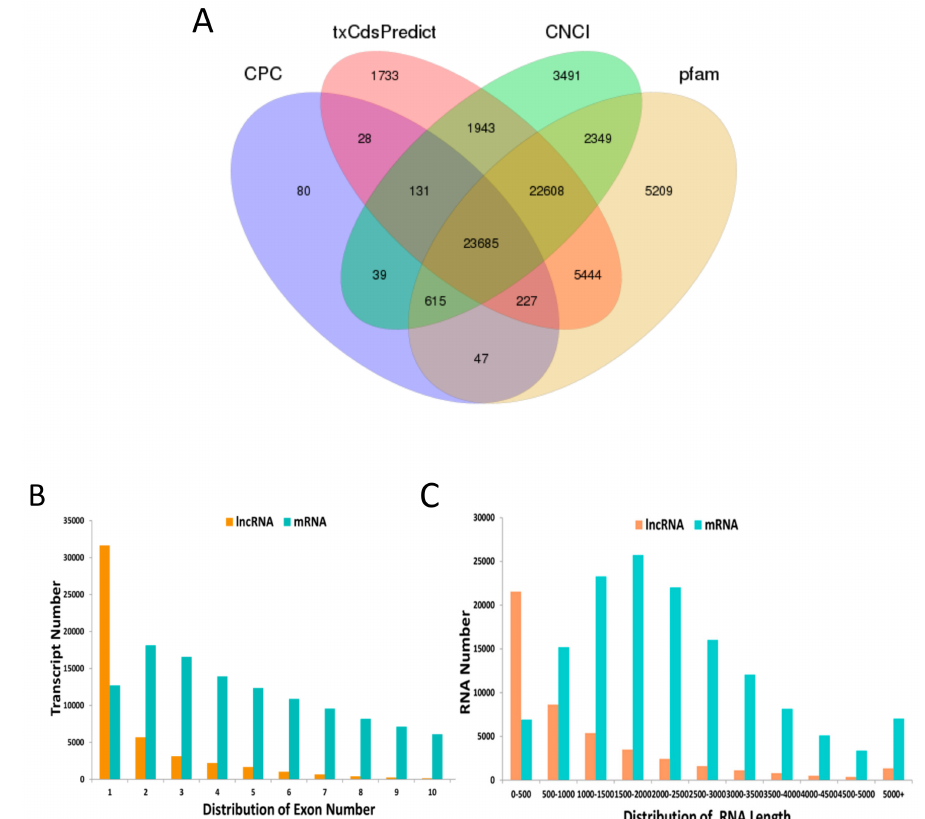
Figure 1. Long noncoding RNA (lncRNA) and mRNA characterization. ( A ) Venn diagram for screening results of the lncRNA by four software (Coding Potential Calculator (CPC), txCdsPredict, Coding-Non-Coding Index (CNCI), and Pfam). ( B ) The distribution of the lncRNA and mRNA exon number. ( C ) The distribution of lncRNA and mRNA